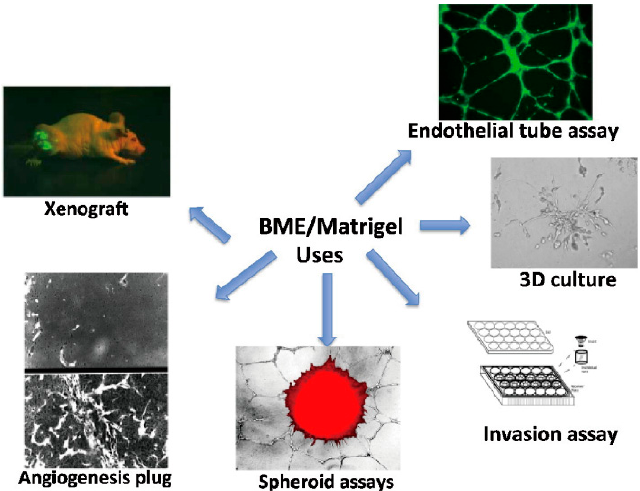
Figure 5. A schematic diagram of in vitro and in vivo assays in which Matrigel is mainly used. Reprinted from [56]. Copyright (2014) Elsevier.